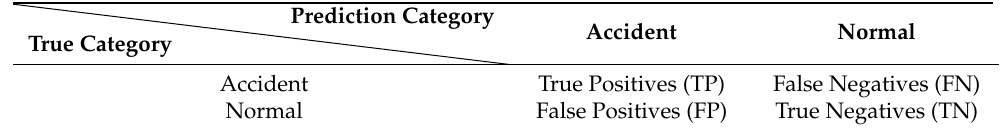
Table 2. Confusion matrix.